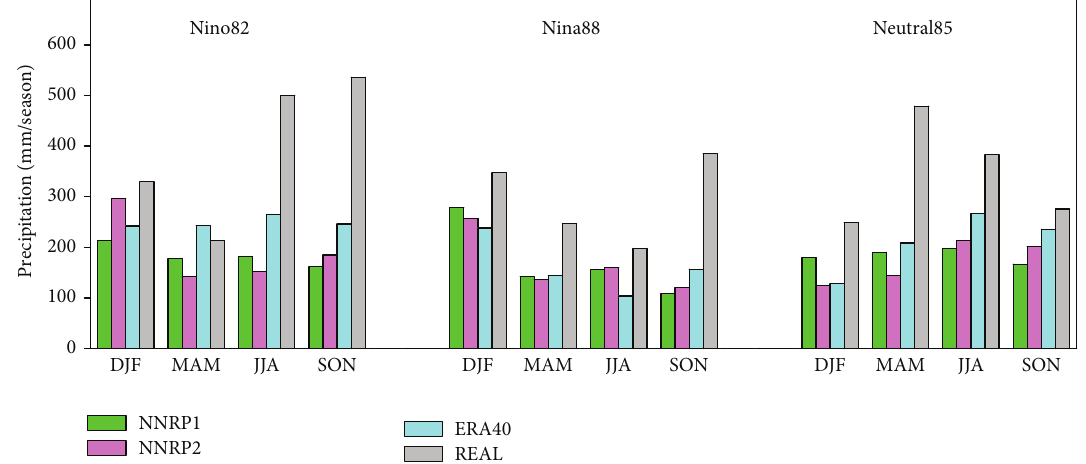
Figure 2: Seasonal precipitation for three simulations (colored) and REAL data (gray).